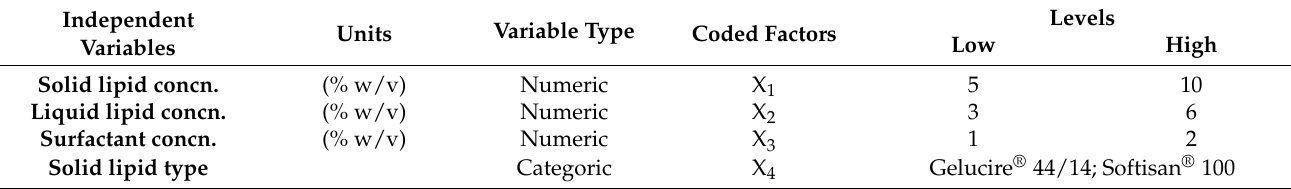
Table 1. Independent variables of the experimental